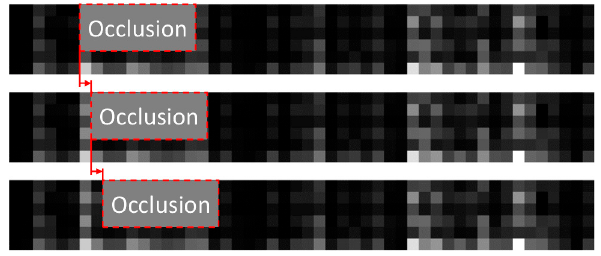
Figure 3. A moving occlusion window partially covers test images while the accuracy of the convolutional neural network is being evaluated. convolutional neural network is being